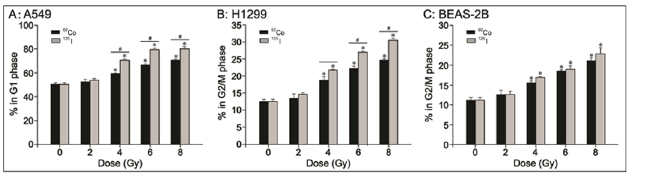
Fig 2. Cell cycle analysis by flow cytometry. A: G 1 arrest of A549 cells irradiated with the two radiation sources; B, C: G 2 /M arrest of H1299 and BEAS-2B cells after irradiation with the two radiation sources. * indicates a significant difference (P < 0.05) when comparing 2, 4, 6 and 8 Gy irradiation by the two radiation sources and control (0 Gy) treatment, and # indicates a significant difference (P < 0.05) when comparing the two radiation treatments of the same dose. Bars, standard error (SE).